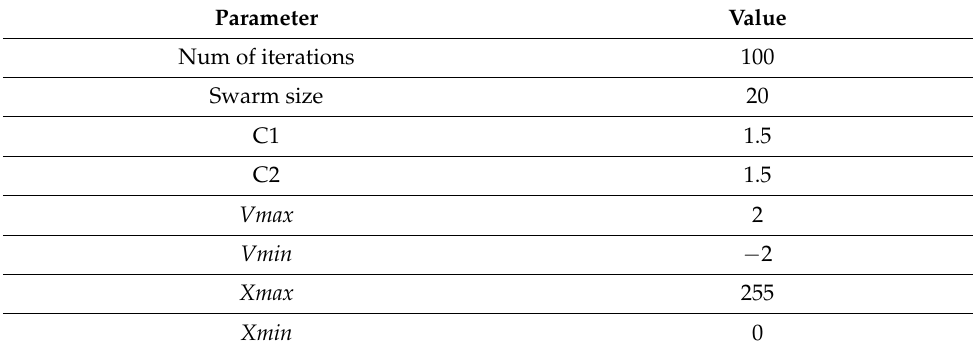
Table 3. Chosen parameters for PSO